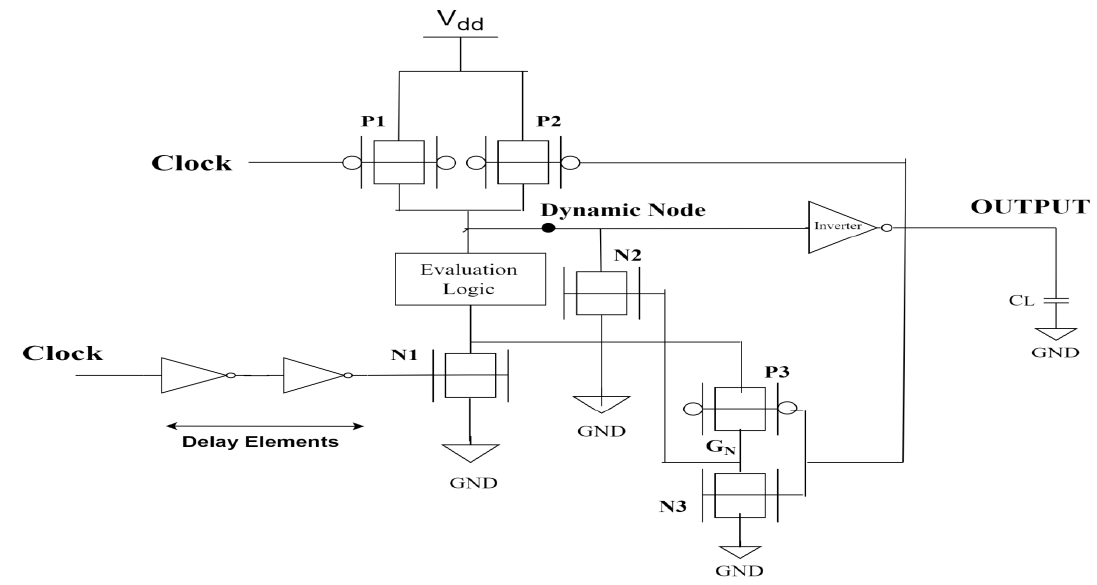
Figure 8. High-speed clocked delay (HSCD) [26].